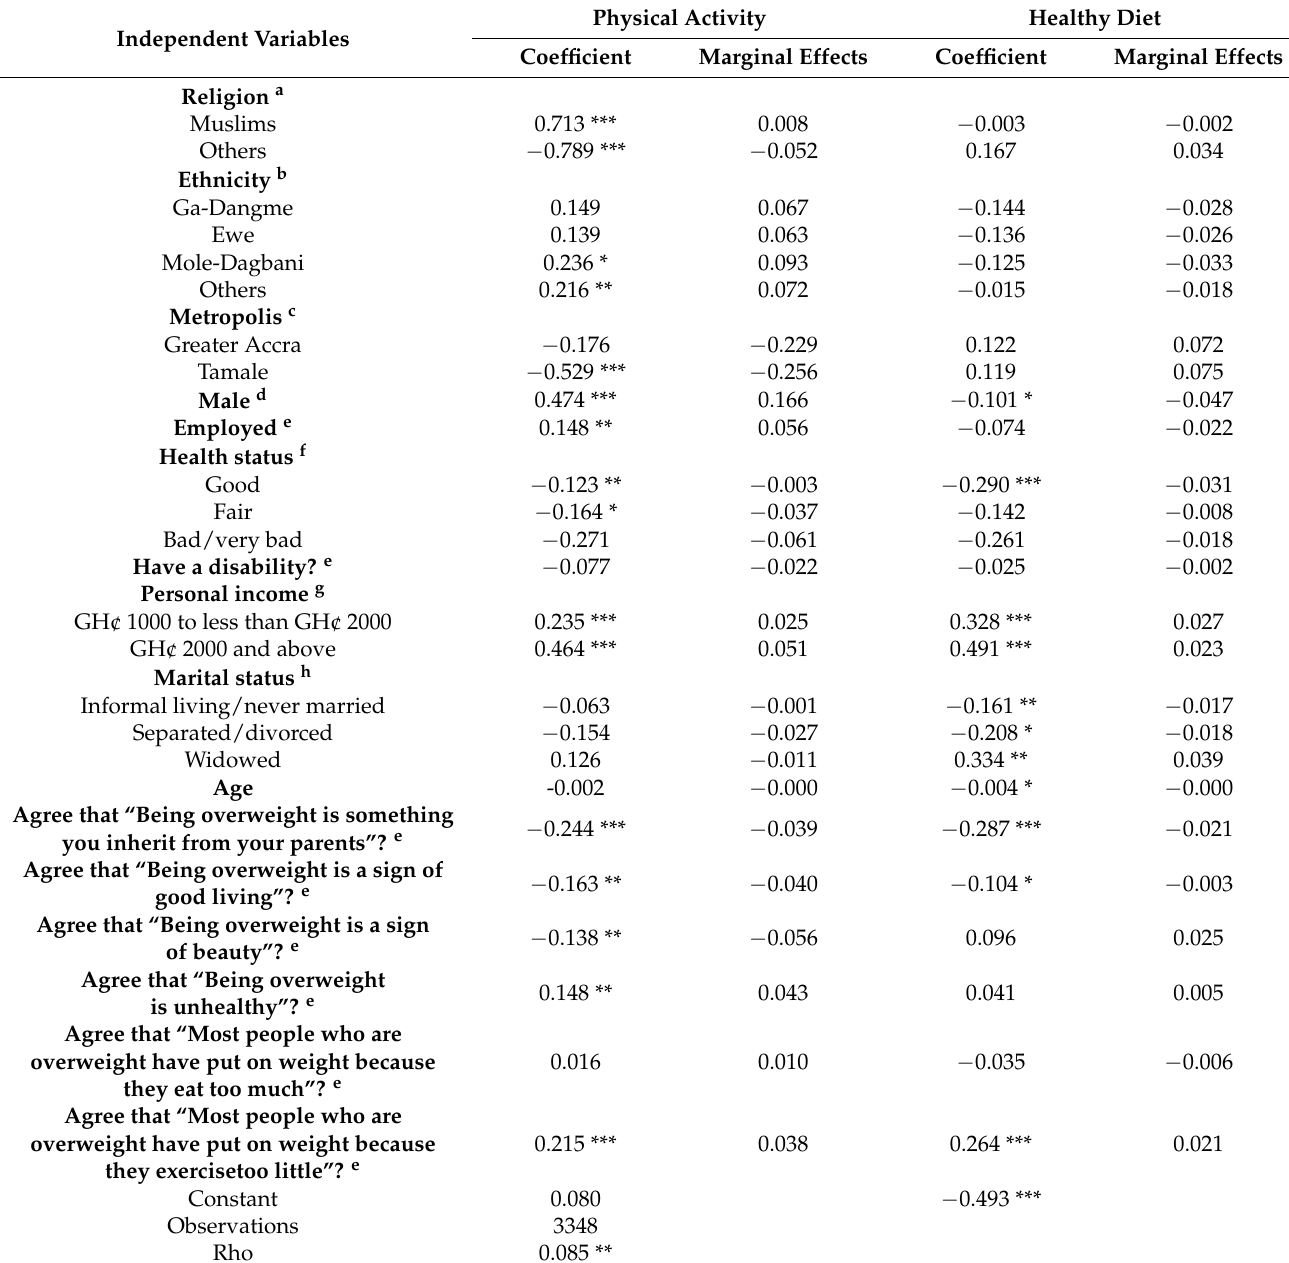
Table 2. Joint estimation results for the probability of engaging in physical activity and eating